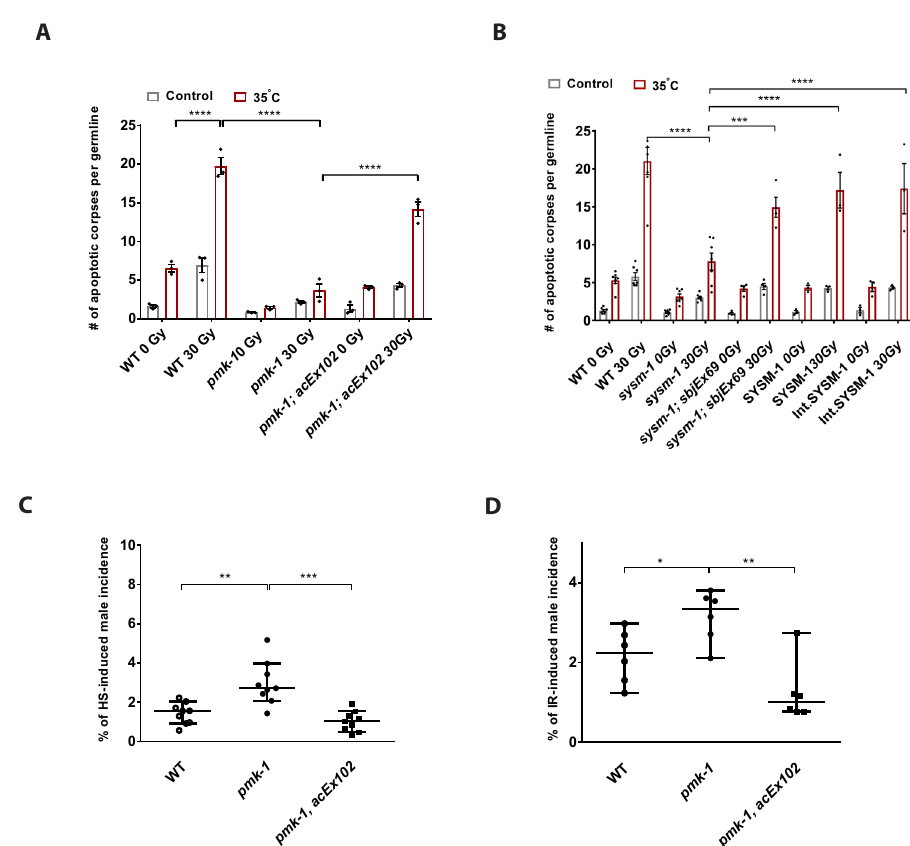
Fig. 4 Intestinal PMK-1/p38 induces germ cell apoptosis and maintains heritable euploidy upon heat stress and IR treatment. A Transient heat stress further promotes IR-induced germ cell apoptosis in an intestinal PMK-1-dependent manner. The graph summarizes n = 3 independent experiments, and each dot indicates one independent experiment. Each experiment includes 8 – 15 germlines per condition scored 6 h post-IR (Young adult worms were heat shock treated at 35 °C for 10 min and subsequently exposed to 30 Gy of IR). Error bars show mean ± s.e.m. (Two-way ANOVA with Tukey ’ s multiple comparison test. WT(0 Gy)35 °C:WT(30Gy)35 °C **** p < 0.0001, WT(30 Gy)35 °C:pmk-1(30 Gy)35 °C **** p < 0.0001, pmk-1(30 Gy)35 °C:pmk-1;